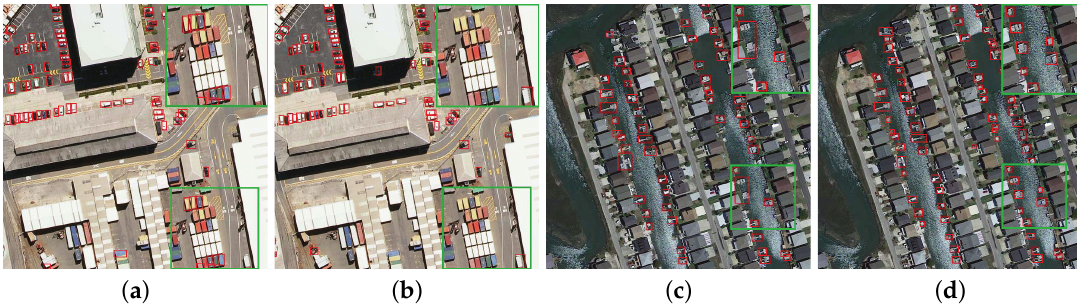
Figure 9. The effectiveness of feature filtration module. Panels ( a , c ) show the detecting results without feature filtration module and panels ( b , d ) provide the results with this